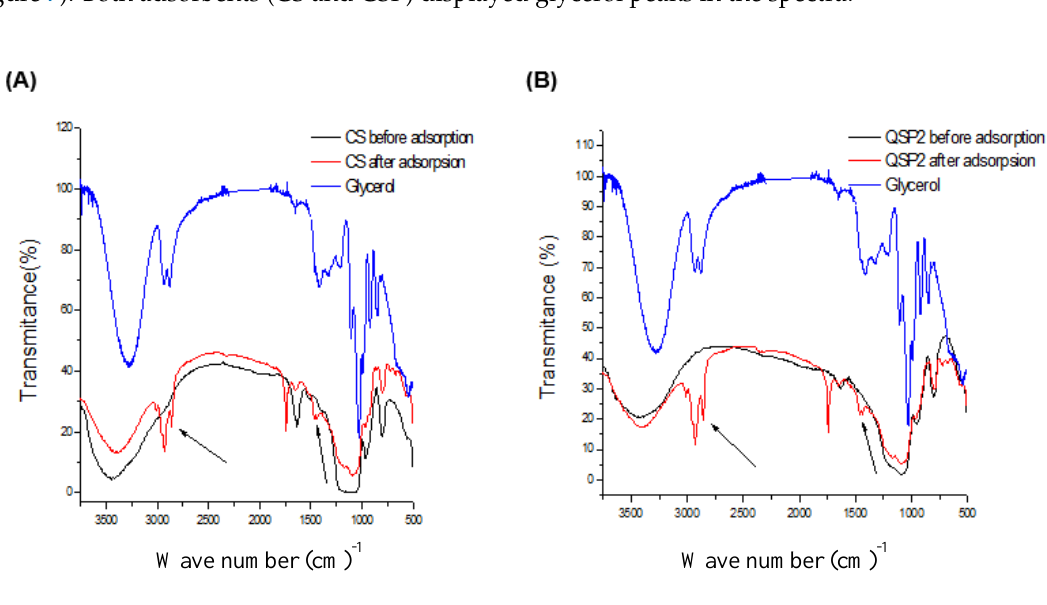
Figure 7. FTIR spectra of CS ( A ) and CSP ( B ) before and after adsorption.